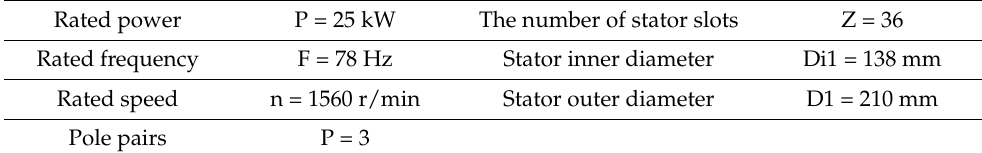
Table 1. Main parameters of motor.